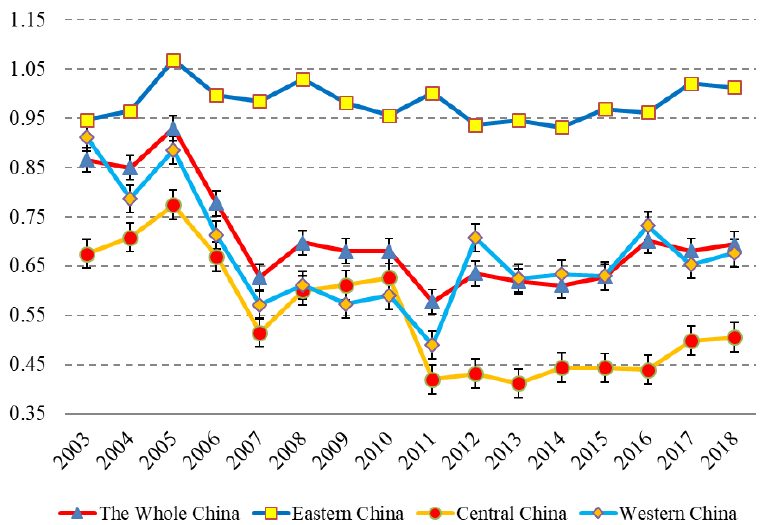
Figure 3. Eco-efficiency of aquaculture in eastern, central and western China from 2003 to 2018.